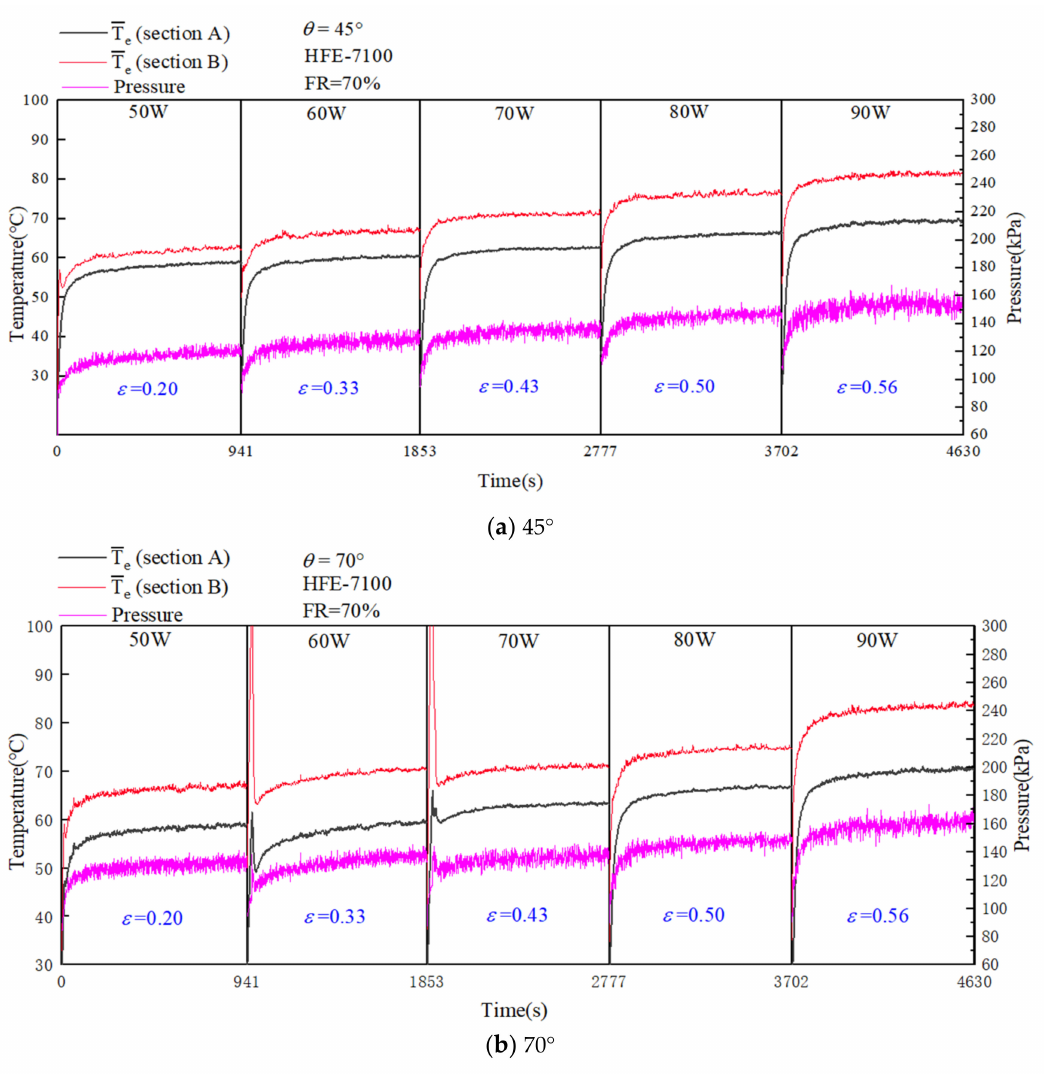
Figure 9. Variation of average temperature and internal pressure of evaporation section with time under different installation angles of HFE-7100 working